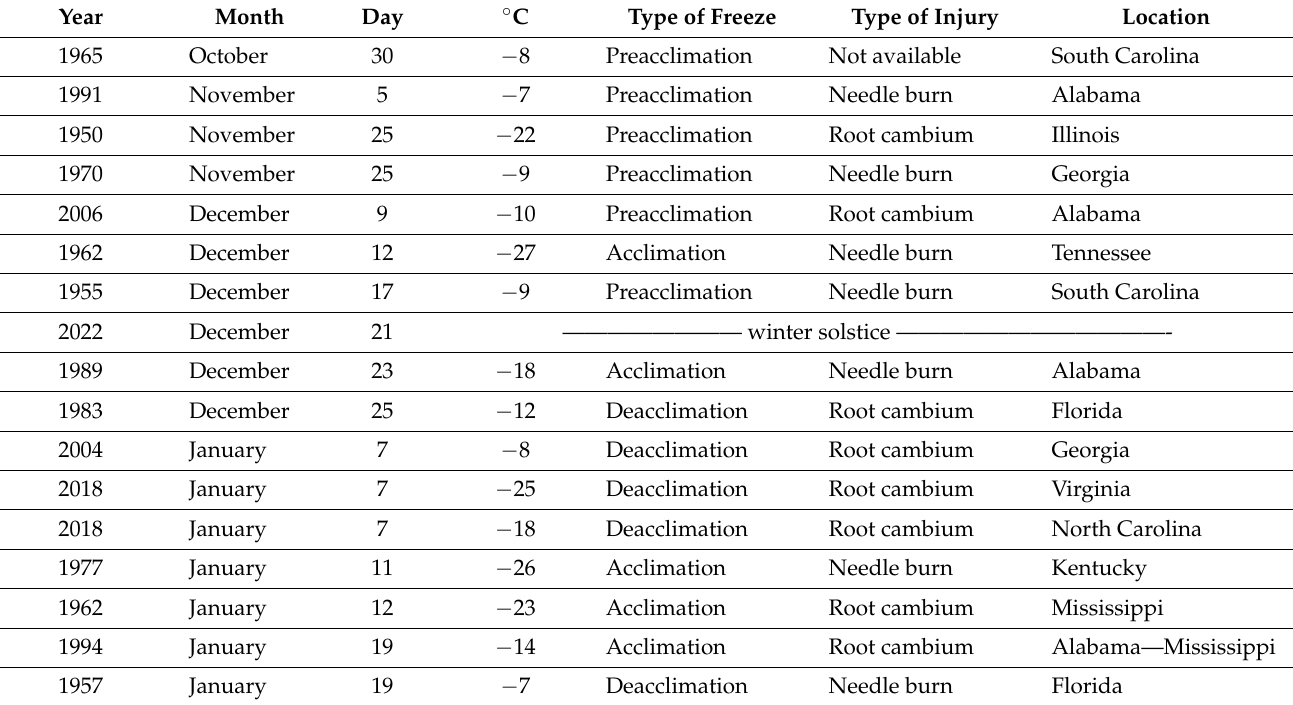
Table A1. Freeze events, type of freeze and type of injury reported on conifers in the eastern United